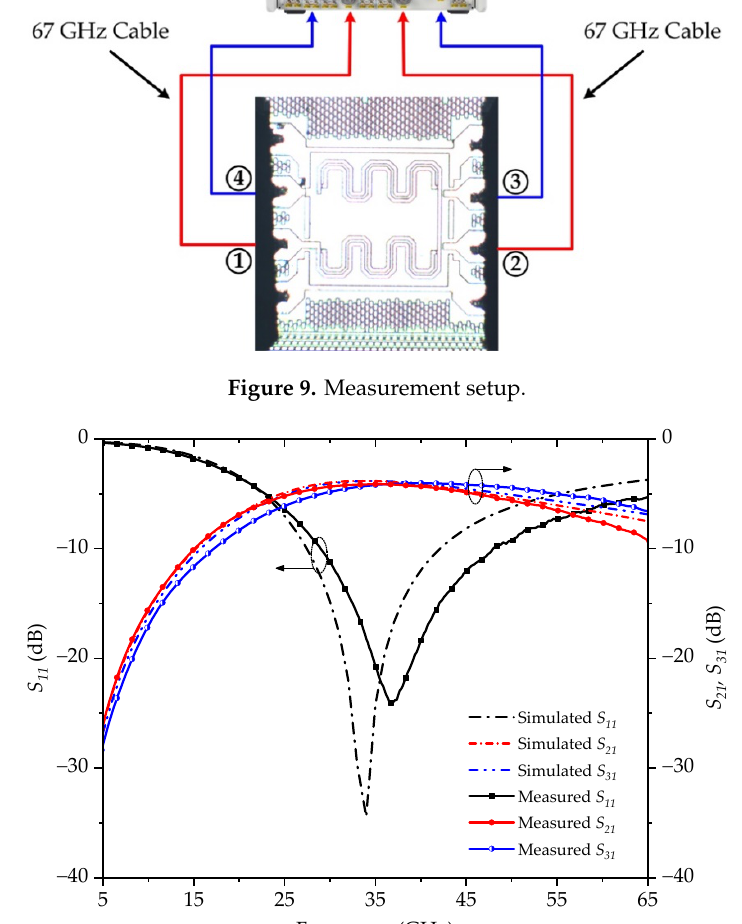
Figure 10. Simulated and measured performance of the proposed balun.